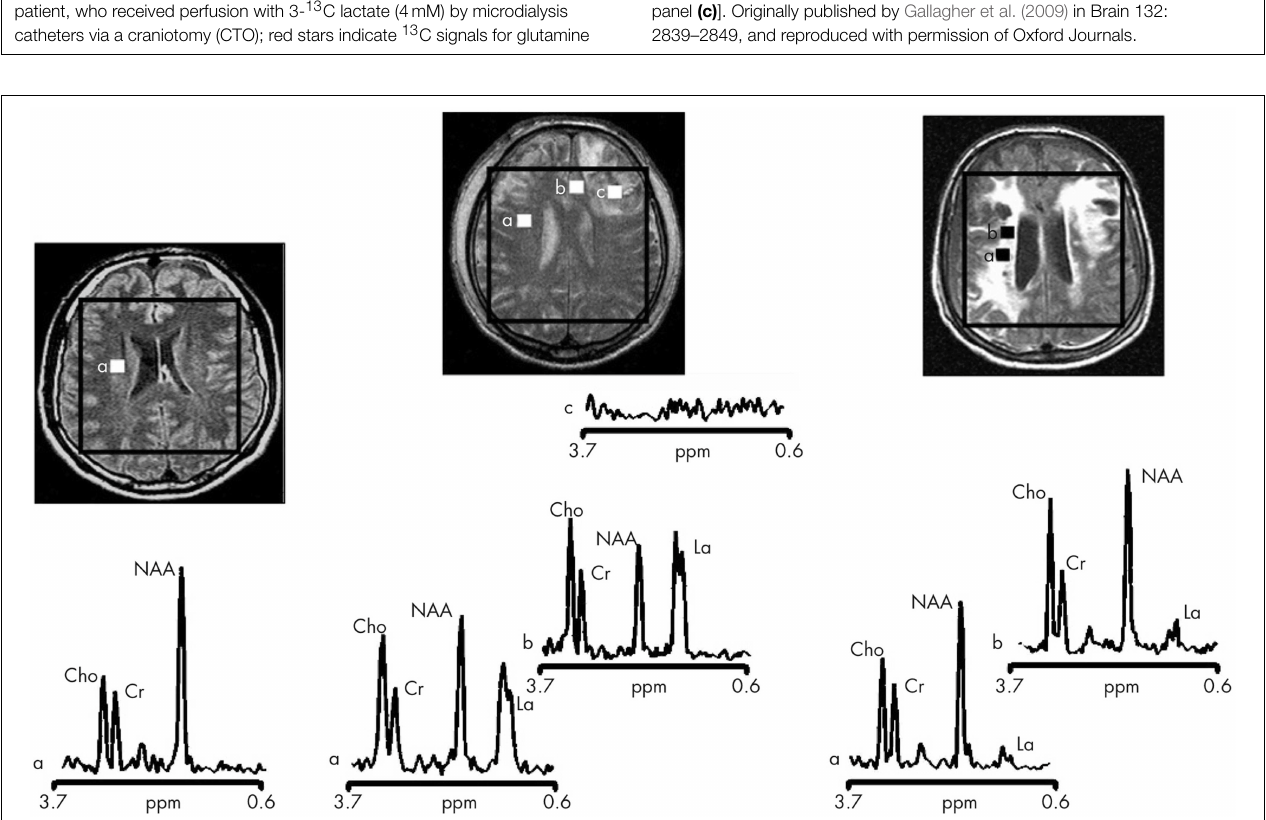
spectra of Patient 1 (central panel) show more pronounced metabolic abnormalities than those of Patient 8 (right panel), despite the fact that Patient 8 showed markedly more abnormalities on conventional MRI. In the spectra of Patient 1 (central panel), metabolic abnormalities are clearly evident in the normal appearing brain. Finally, in Patient 1, voxels inside the focal hematoma (c in central panel) were excluded to avoid the artifacts that could be derived by the cerebral haemorrhagic contusion. Cr, creatine. Reproduced from J Neurol Neurosurg Psychiatry, Marino et al. 78: 501–507 (2007) with permission from BMJ Publishing Group